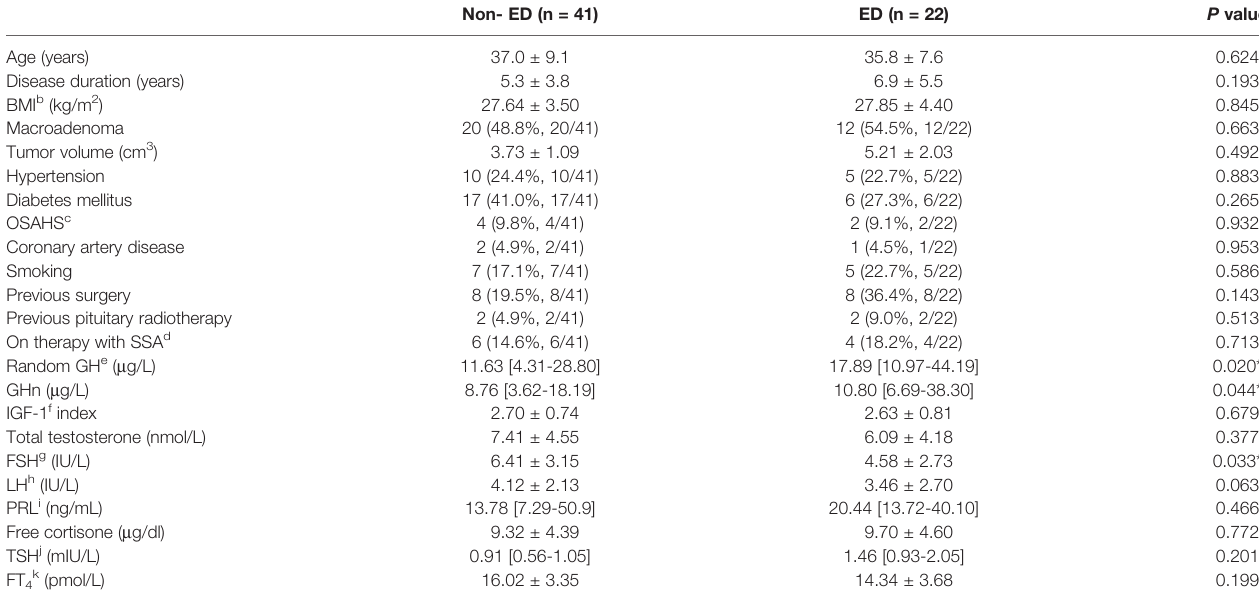
TABLE 2 | Clinical characteristics of ED a and non-ED patients.